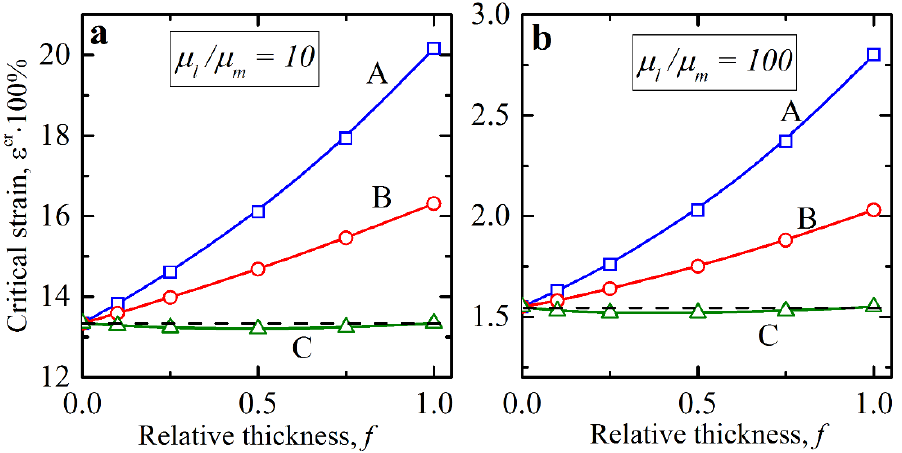
Figure 5. Critical strains in the non-dilute composites with interphasial layers. The shear modulus contrast µ l / µ m is 10 ( a ) and 100 ( b ) and the volume fraction v l = 0.2. Horizontal dashed black line corresponds to the case of ideal composites.